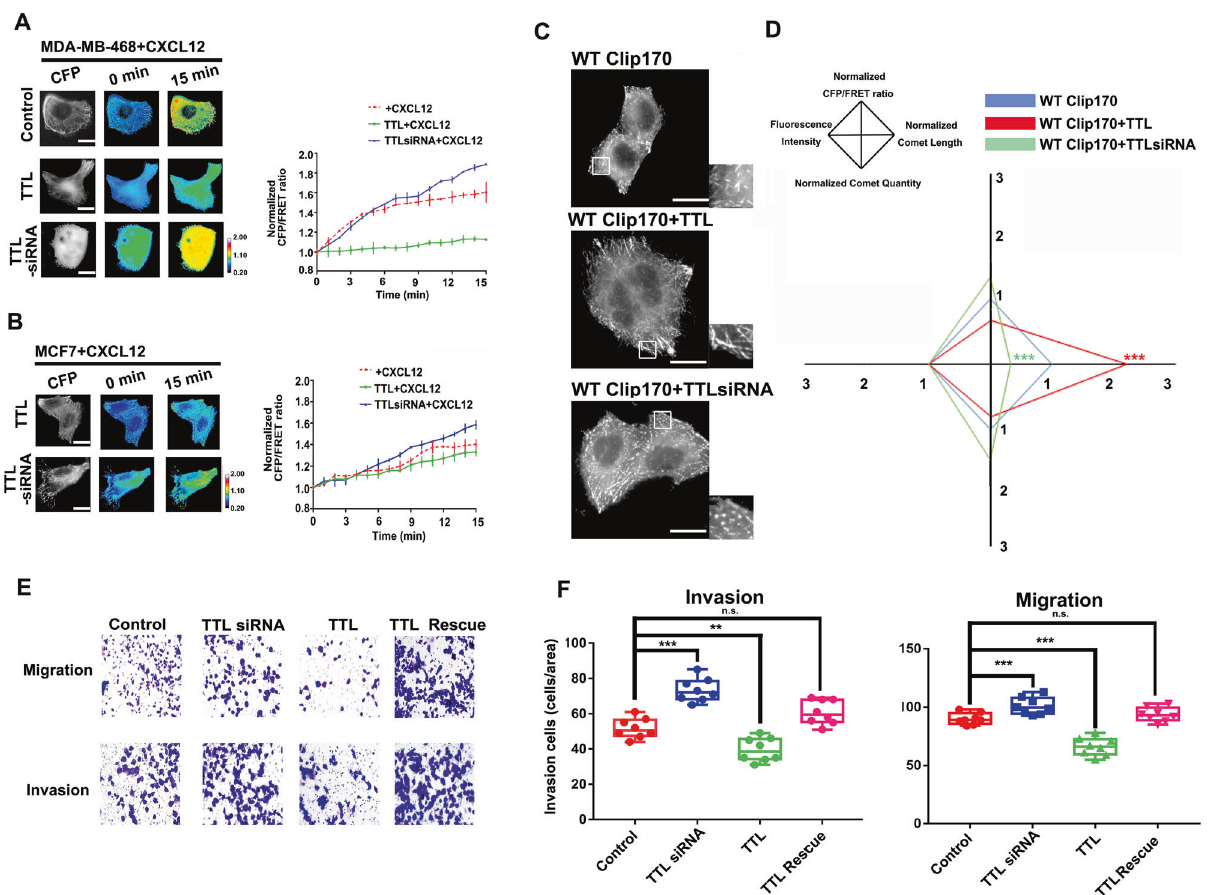
Fig. 2 TTL expression regulates Clip170 tension and breast cancer invasion and migration. A Left panel: 15-min time-lapse images of FRET analysis in MDA-MB-468 cells expressing the Clip170-cpstFRET probe and transfected with the TTL siRNA or TTL overexpression plasmid after CXCL12 treatment. Calibration bar, 0.2 – 2.0; scale bar, 10 μ m. Right panel: Normalized CFP/FRET signals for the whole cell corresponding to tension versus time, respectively. (Mean ± SEM, n ≥ 6 cells in each group) ( B ) Left panel: 15-min time-lapse images of FRET analysis in MCF7 cells expressing the Clip170-cpstFRET probe and transfected with the TTL siRNA or TTL overexpression plasmid after CXCL12 treatment. Calibration bar, 0.2 – 2.0; scale bar, 10 μ m. Right panel: Normalized CFP/FRET signals for the whole cell corresponding to tension versus time, respectively. (Mean ± SEM, n ≥ 6 cells in each group). C Representative CFP images of MDA-MB-468 cells expressing the Clip170-cpstFRET probe and transfected with the TTL siRNA or TTL overexpression plasmid. D Normalized CFP/FRET signals, comet lengths, comet quantities, and fl uorescence intensities for the whole cell in different groups (scale bar, 10 μ m, n ≥ 6 cells in each group, *** P < 0.001 compared with WT- Clip170 alone group). E Representative images of the migration and invasion of MDA-MB-468 cells in the control, TTL siRNA, TTL overexpression and TTL rescue groups. F Quantitative analysis of the migration and invasion cells (Mean ± SEM, n = 3 independent experiments and at least three fi elds, *** P < 0.001 compared with WT-Clip170 alone